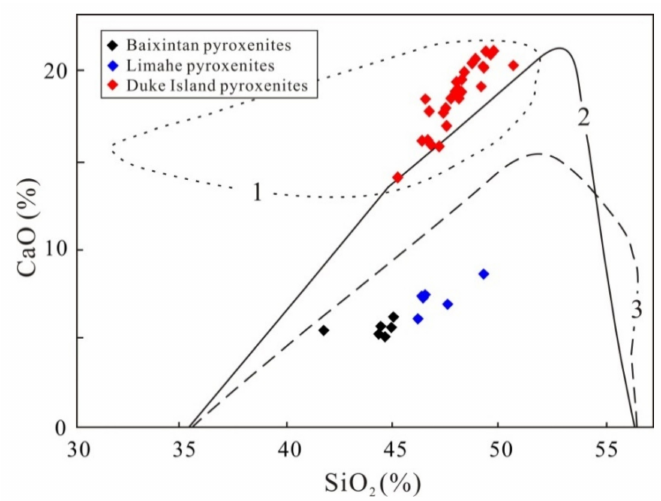
Figure 12. SiO 2 -CaO diagram of pyroxenites from the Baixintan, Limahe, and Duke Island intrusions (after [116]. 1 = Alaskan field, 2 = Ophiolitic field, and 3 = Layered intrusion field. Data source of Baixintan: [84]; data sources of Duke Island: [114,115]; data sources of Limahe: